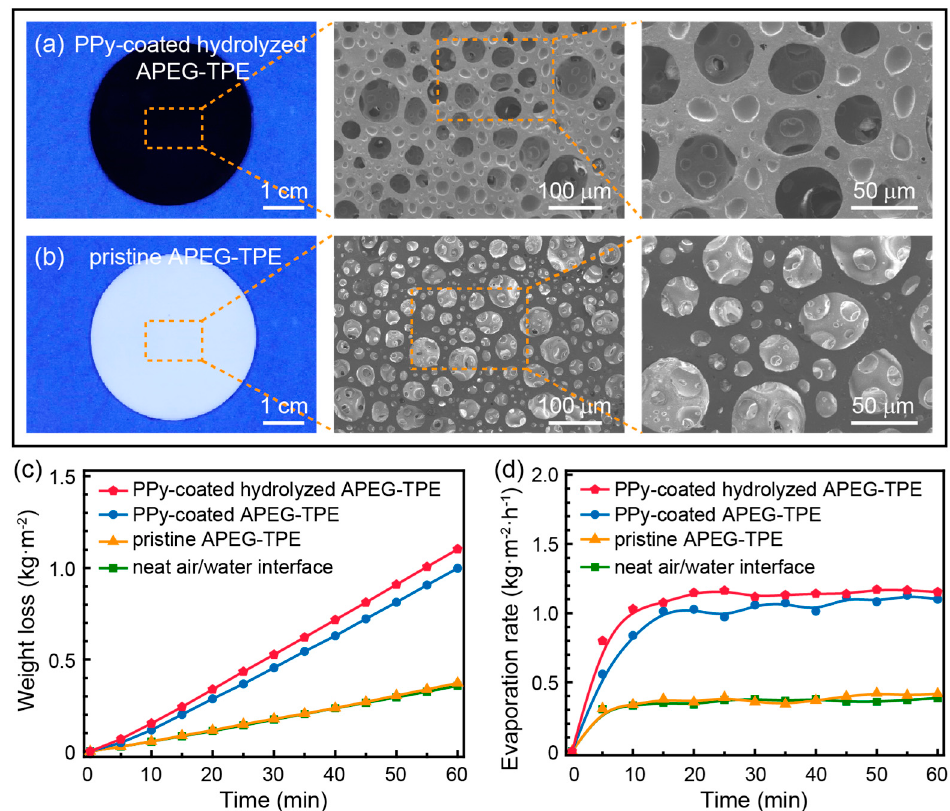
Figure 4. Performances of APEG-TPEs for solar vapor generation. Optical and SEM images of ( a ) PPy-coated hydrolyzed APEG-TPEs and ( b ) pristine APEG-TPEs. ( c ) Accumulative water losses and ( d ) evaporation rates of different APEG-TPEs as a function of irradiation time.